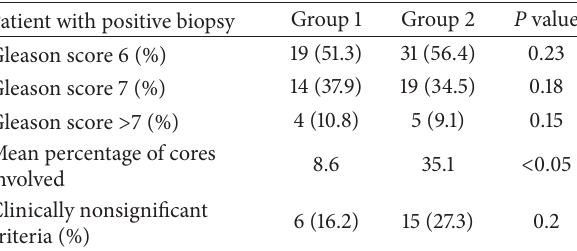
Table 2: Distribution of anatomopathological findings among patients with positive biopsy in each